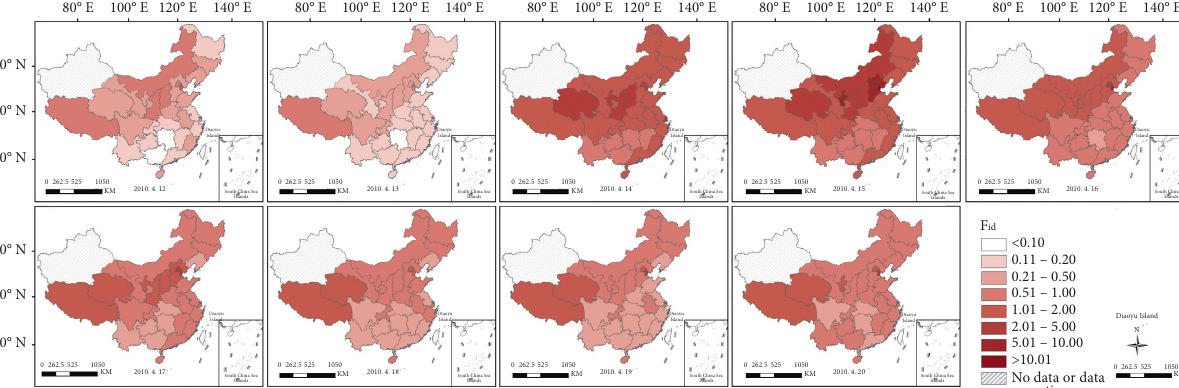
Figure 2: F id before and after the Yushu earthquake